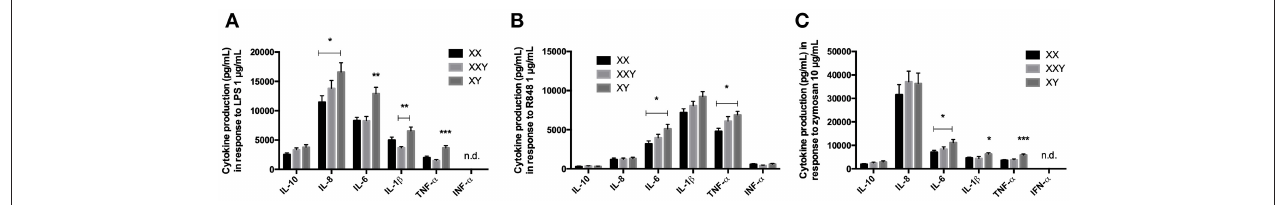
FIGURE 1 | Mean ± SEM of IL-10, IL-8, IL-6, IL-1 β , TNF- α , and IFN- α productions in whole blood after stimulation with LPS 1 µ g/mL (A) , resiquimod 1 µ g/mL (B) and zymosan 10 µ g/mL (C) in men, women, and subjects with Klinefelter syndrome. Whole blood was mixed with culture medium then incubated with the ligand for 24h. The production of inflammatory cytokines was measured in the supernatant by flow cytometry. BD FACSDiva TM software version 6.1.2 for Windows was used to acquire the data and BD FCAP Array TM software version 1.0.1 for Windows was used to analyze the data. (* p < 0.05, ** p < 0.01, *** p < 0.001 using one-way ANOVA for independent groups with n =